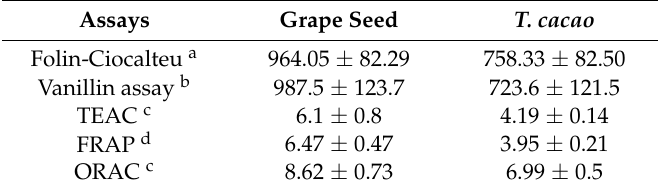
Table 3. Values for different antioxidant measurements performed with grape seed and cacao extracts. Values are expressed as mean ±